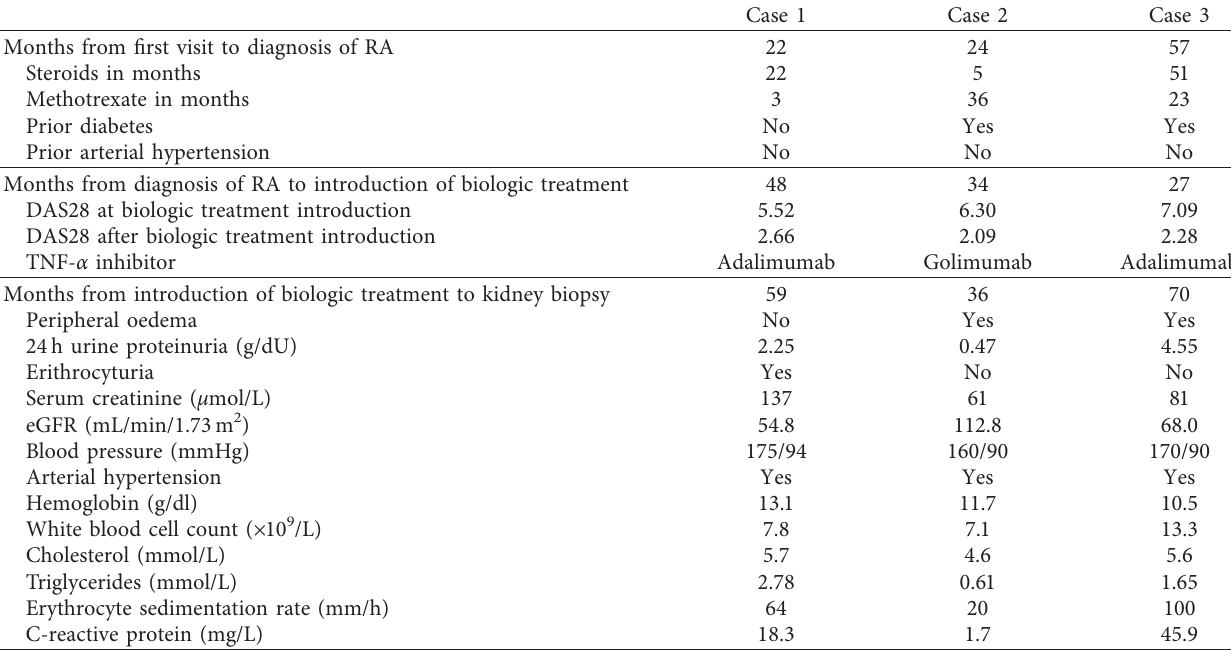
Table 1: Clinical characteristics of three RA patients with IgA glomerulonephritis following anti-TNF- α therapy.